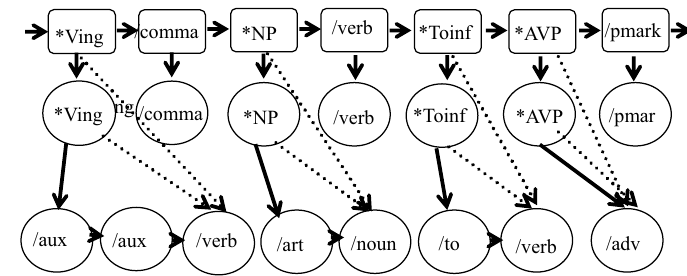
Figure 6: Sentence “ Having been rcpaircd.thc clock began.